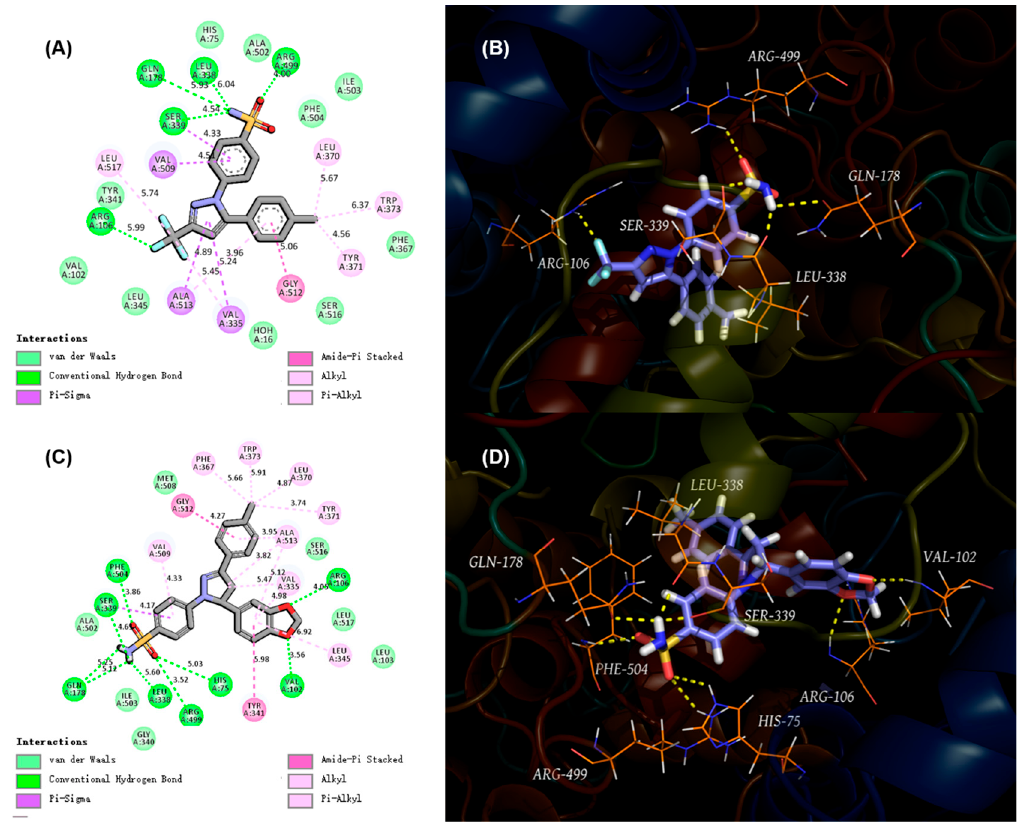
Figure 8. Characterization of molecular docking with COX-2 (PDB ID: 3LN1). ( A ) Molecular docking 2D spatial modeling of Celecoxib with the COX-2 binding site. ( B ) Molecular docking 3D spatial modeling of Celecoxib with the COX-2 binding site. ( C ) Molecular docking 2D spatial modeling of compound 4b with the COX-2 binding site. ( D ) Molecular docking 3D spatial modeling of compound 4b with the COX-2 binding site.